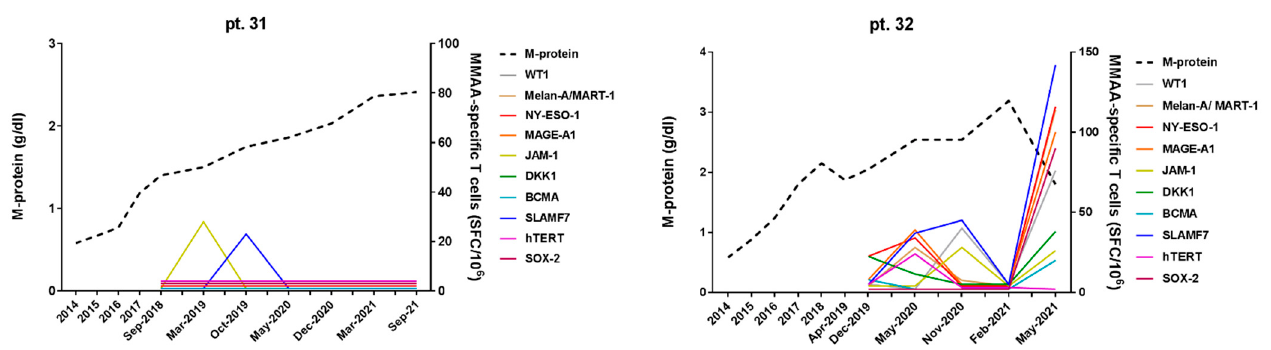
Figure 3. Correlation between MMAA-specific T-cell responses and disease course in two patients with progressive monoclonal gammopathy. In these graphs, frequencies of IFN γ -secreting antineo- plastic T cells targeting the different MMAAs (right, y -axis; colored continuous lines), as assessed in PB samples, at different time-points of follow-up ( x -axis), are correlated with M-protein levels (left, y -axis; black dotted line). Different y -axis scales are applied in the graphs, according to patient’s dataset. Left panel : a 45-year-old man (pt. 31), with an initial diagnosis of low-risk IgG-kappa MGUS in 2014, showed a progressive disease early, with M-protein raising from 0.58 to 1.75 g/dL in 5 years of follow-up. In November 2019, based on M-protein levels >1.5 g/dL, FLC ratio 3.27 and 15–20% of clonal PCs in the BM, in the absence of magnetic resonance imaging (MRI) lesions, a diagnosis of low risk SMM was made. In March 2021, further increments of both M-protein level (2.36 g/dL) and FLC ratio (10.4) were recorded, leading to the definition of intermediate-risk SMM. In this case, all types of MM-specific IFN γ -producing T cells were invariably negative (<60 SFCs/10 6 cells) in several time-points analyzed, from September 2018 to March 2022 (not shown). Right panel : a